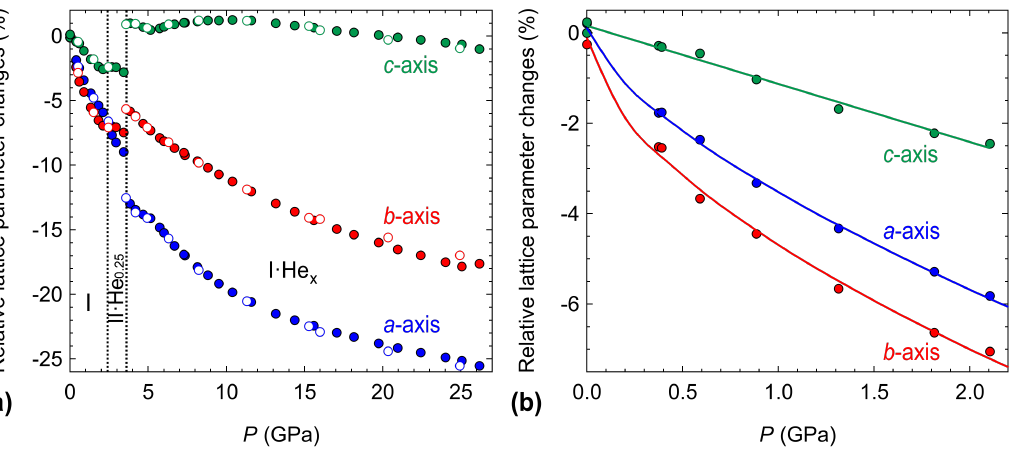
Figure 2. ( a ) Pressure dependence of the relative changes in lattice parameters of 4HCB with helium as the PTM. A zoom of the pressure dependence of the ambient phase up to 2.1GPa is given in ( b ), with the solid lines representing the empirical fits for the a - and b -axes, and a linear fit for the c -axis. Decompression points are indicated by the open markers. Transition points are shown by the dotted black lines, and the different phases are indicated by I and